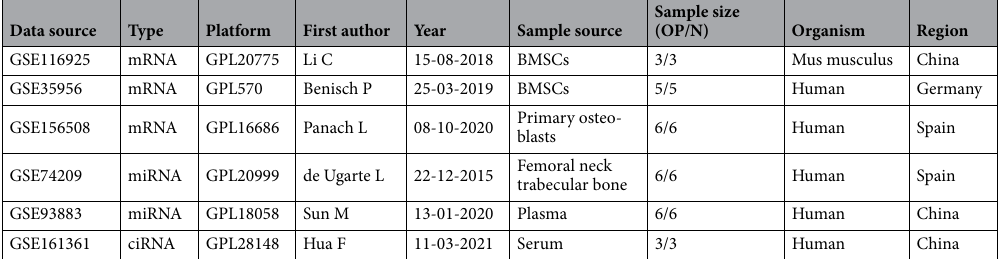
Table 1. Basic information of the microarray datasets from GEO. GEO gene expression omnibus, OP osteoporosis , N normal.